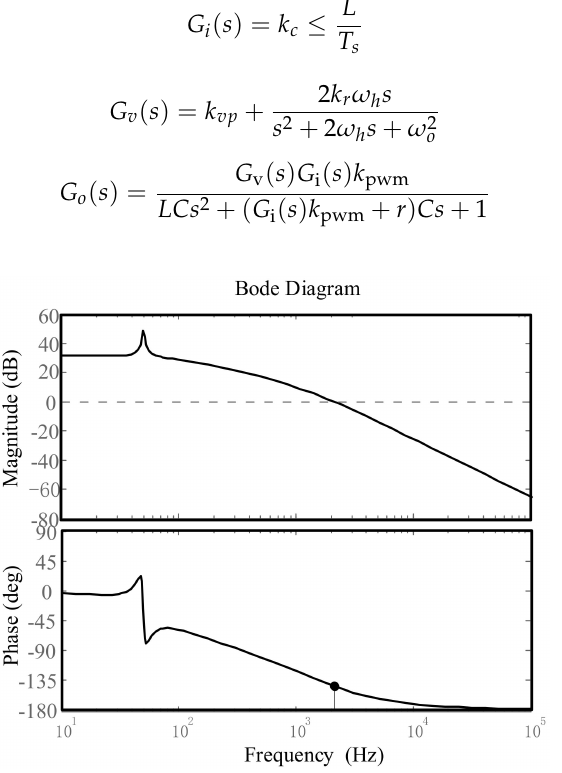
Figure 9. Bode diagram of the system open-loop transfer